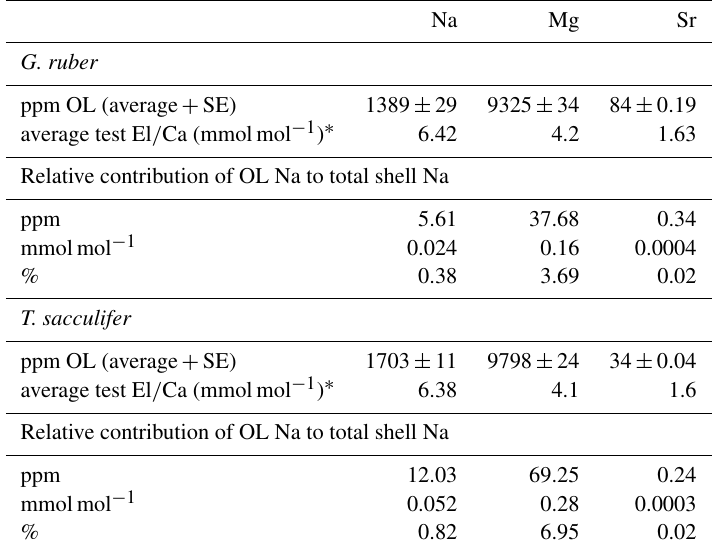
Table 7. Elemental composition of organic linings calculated for shell weight and estimated elemental composition based on OL weight.